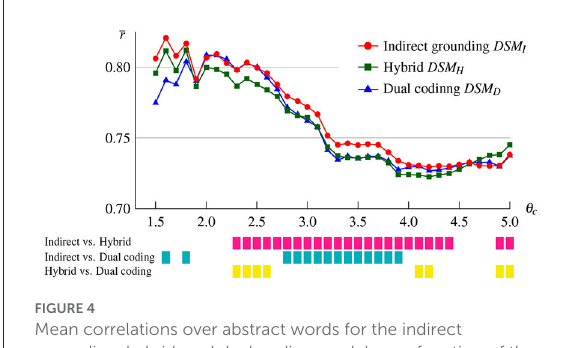
FIGURE4 Mean correlations over abstract words for the indirect grounding, hybrid, and dual coding models as a function of the concreteness threshold θ c . Pairwise differences significant at p < 0.05 are indicated by color bars below the